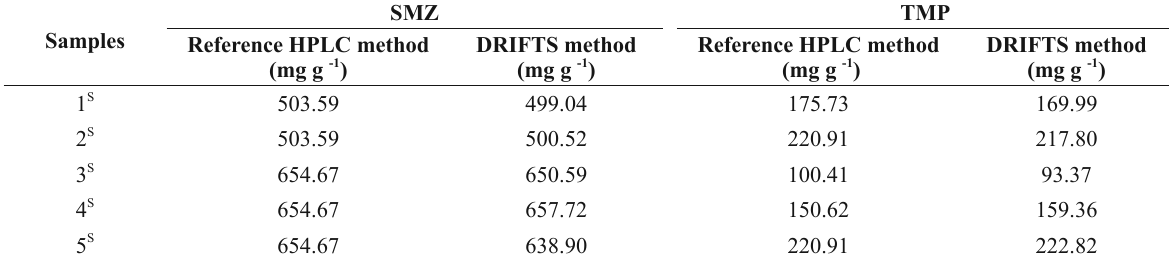
Results of average prediction values for the better si PLS